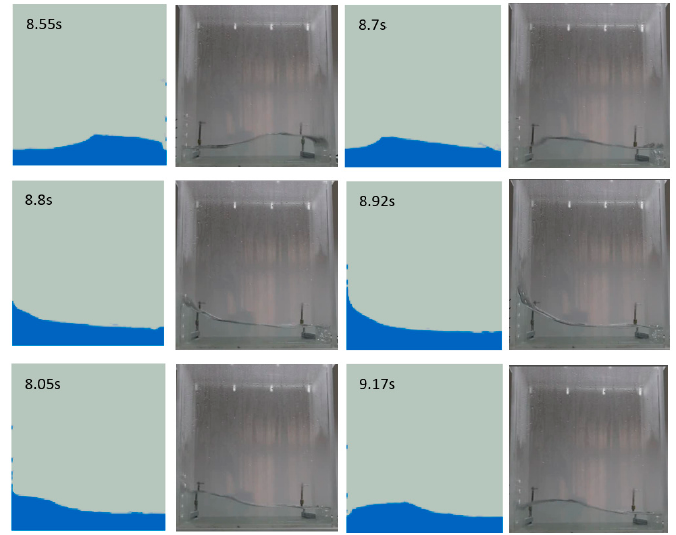
Figure 8. The numerical wave profile and experimental snapshot in six moments between 8.55 s and 9.17 s (amplitude is 7 mm, h = 90 mm, ω = ω 1 ).